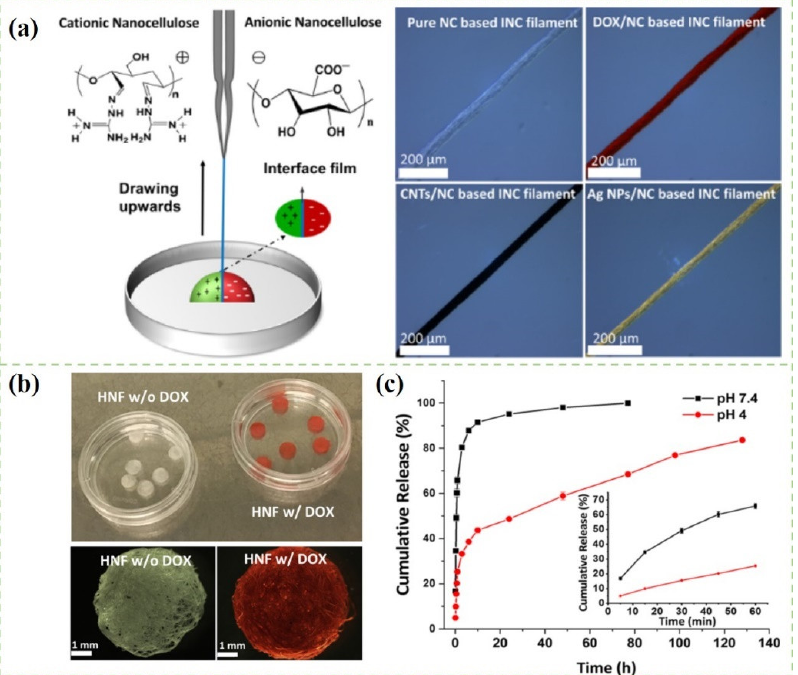
Figure 2. ( a ) Schematic illustration of nanocomposite filament; ( b ) Photography and optical microscopy images of hydroentangled CNCs-based INC filament; ( c ) Cumulative release profiles of DOX-loaded CNCs-based INC filaments in different pH values at 37 °C. The inset shows the cumulative drug release in the first 1 h [76].